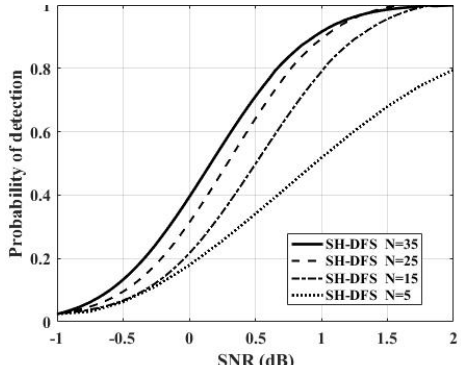
Figure 9. The probability of detection of the clustered distributed system with SH-DFS at a different number of local sensors versus SNR.